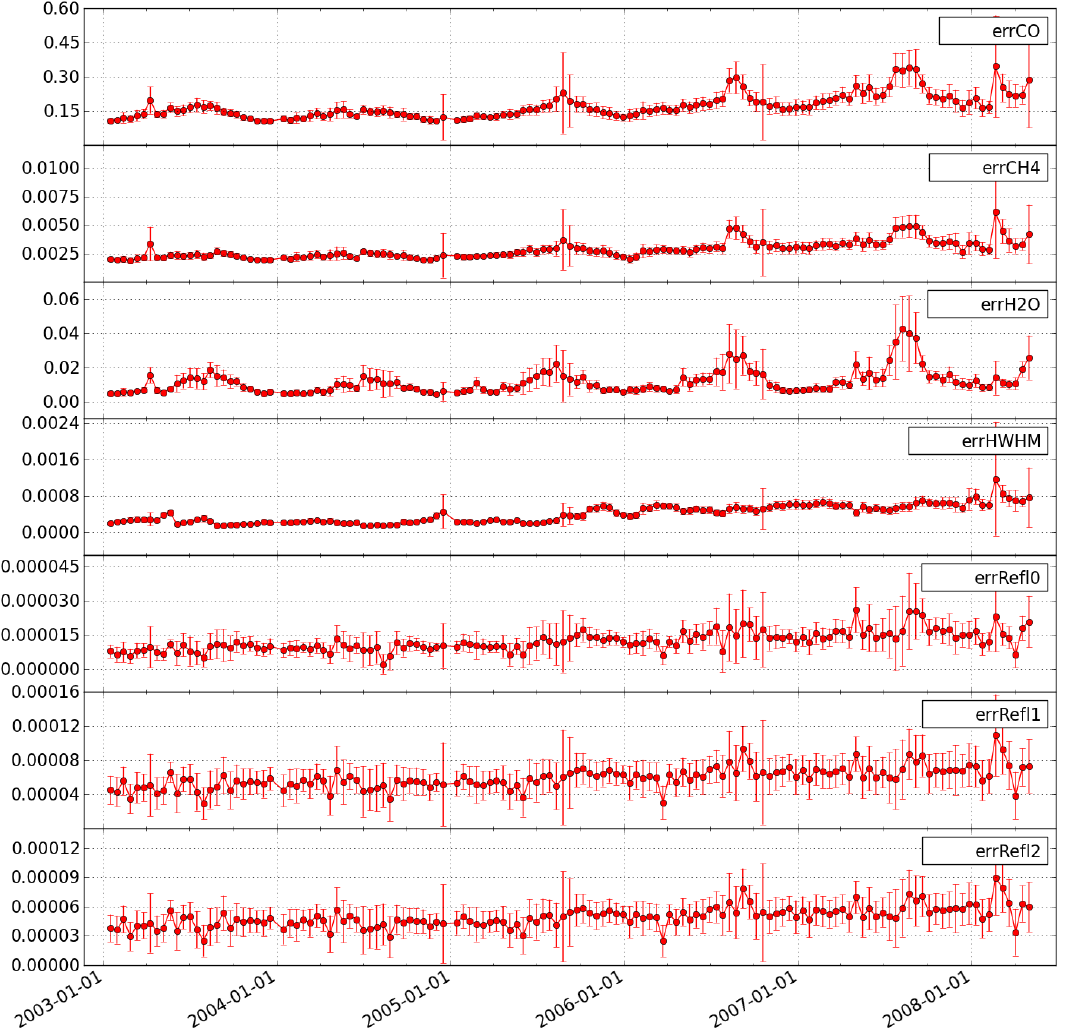
Fig. 13. Time series of 14-day averaged errors of fit parameters (see Fig. 12). From top down: error of the scaling factors of CO, CH 4 and H 2 O, the half width at half maximum of the instrument slit function, and the zeroth, first, and second degree coefficients of the albedo polynomial.